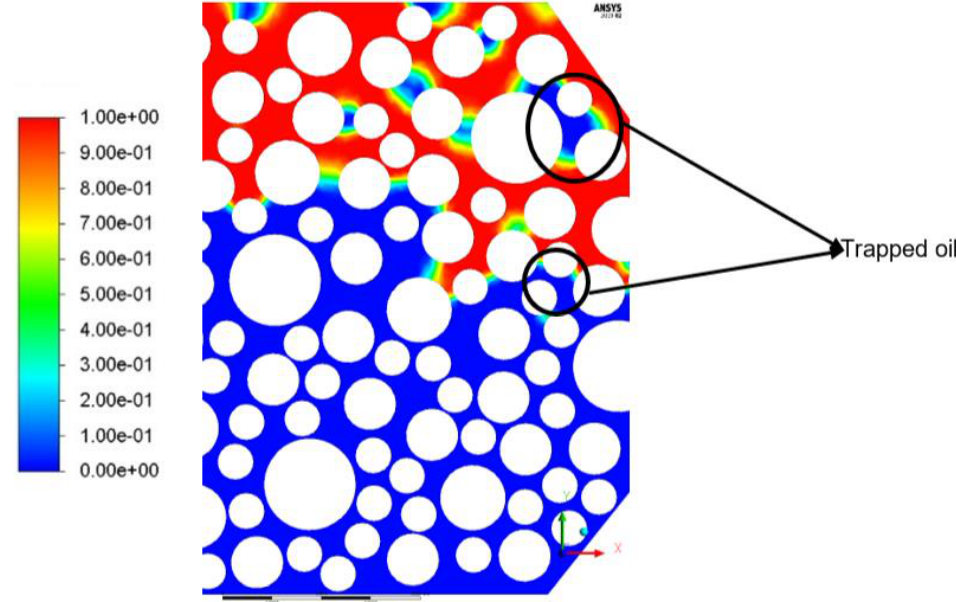
Figure 10. Trapped oil (blue) in the micromodel.